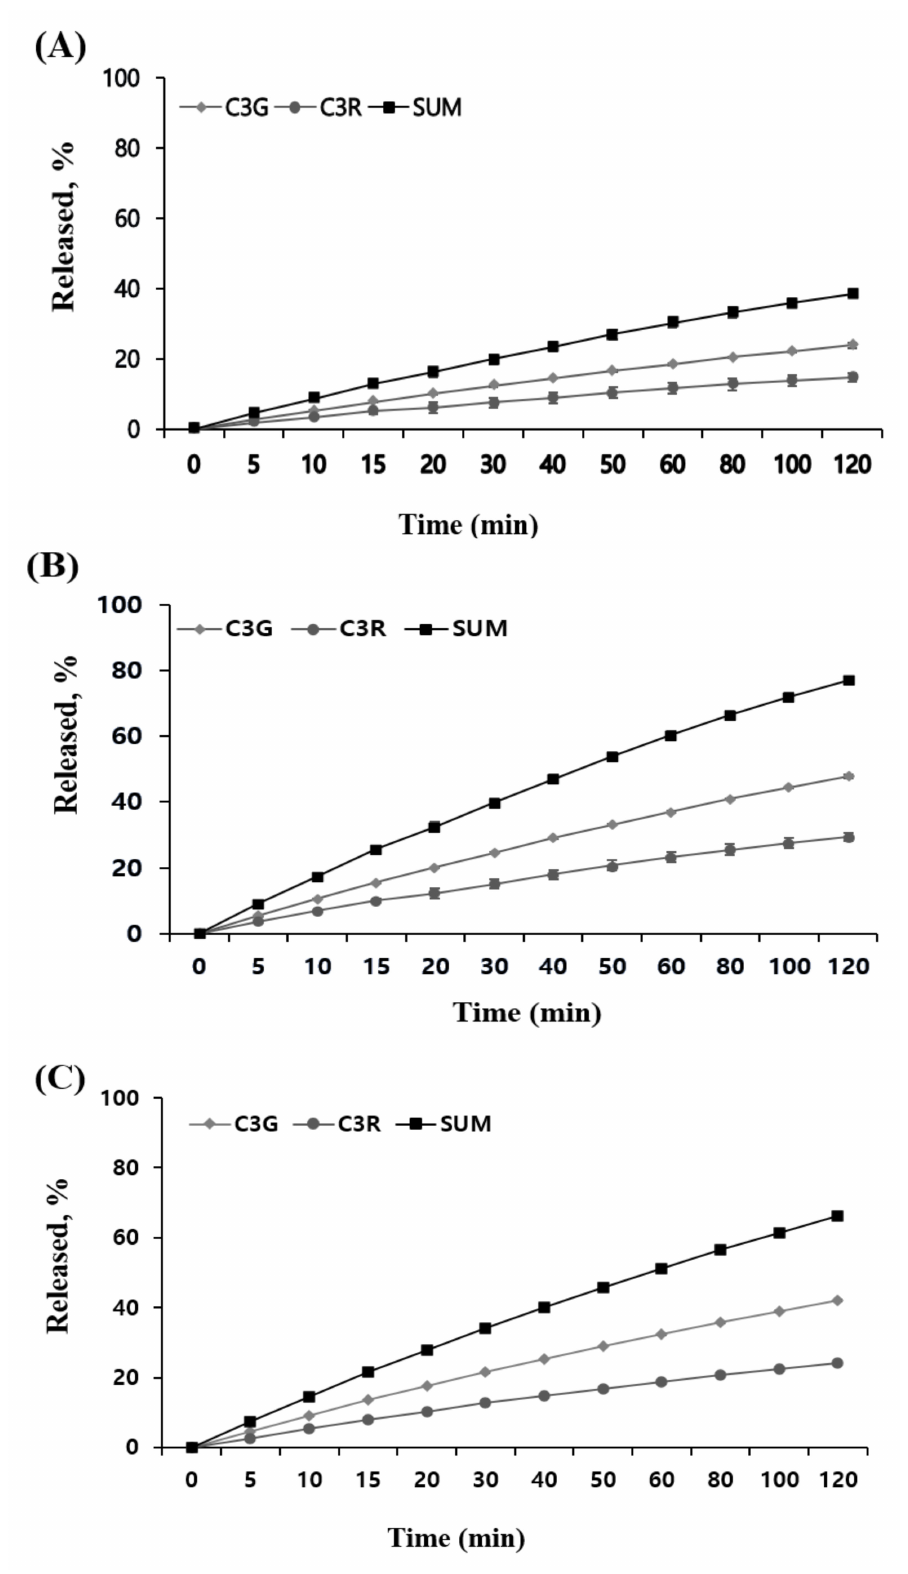
Figure 6. An in vitro release profile of C3G and C3R from ( A ) MUL, ( B ) MUL-ESFs-CA, ( C ) MUL- ESFs-CA-ALG in SGF for 2 h (n = 3, mean ±